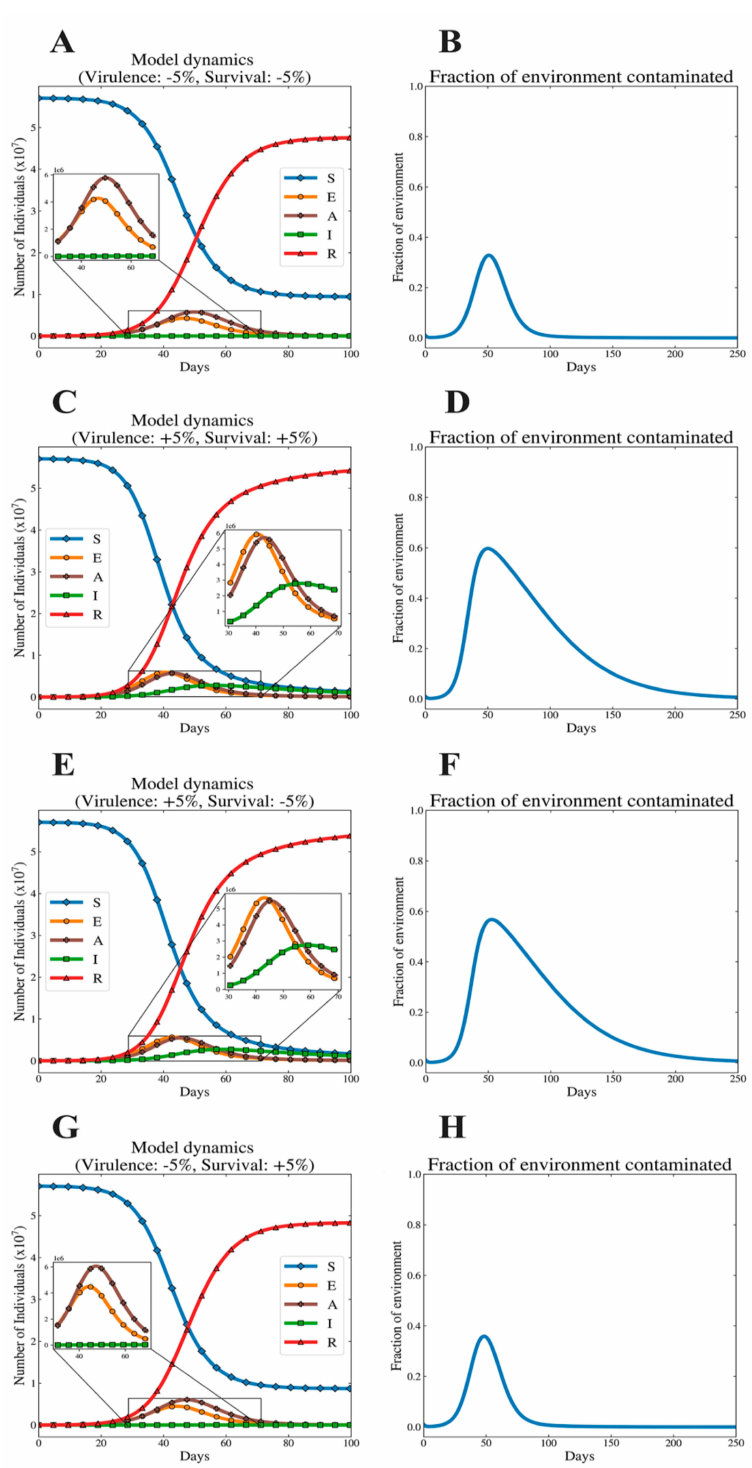
Figure 7. Virus outbreak dynamics for the extreme values of virulence and free-living survival considered for the two di ff erent relationships (positive or negative) between virulence and survival traits: these plots are similar to the illustrative dynamics in Figure 1. Here, we observe the dynamics of disease corresponding to the extreme values presented in Tables 5 and 6. Subfigures ( A , C , E , G ) depict disease dynamics, and ( B , D , F , H ) depict the dynamics of contaminated environments. ( A – D ) correspond to the parameter values considered for the positive correlation scenario, while ( E – H ) correspond to the negative correlation